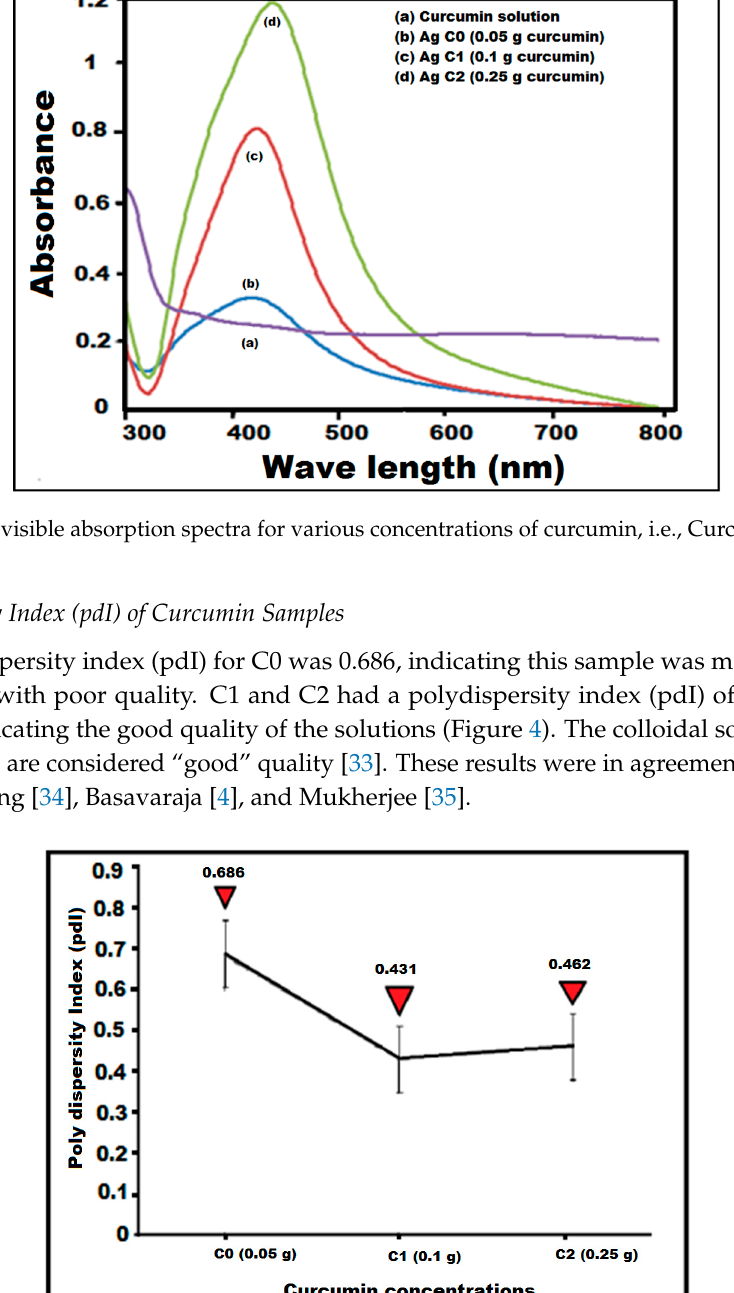
Figure 4. Polydispersity index (pdI) for various concentrations of curcumin, i.e., Curcumin, C0, C1, and C2.